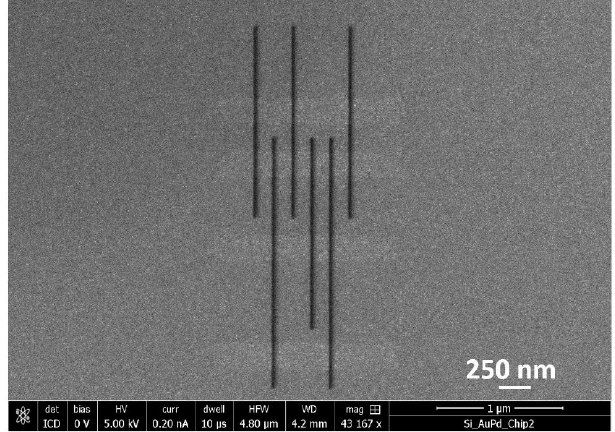
BSE (b) images show brightening in the exposed regions and the integrated AFM line scan of the line profile in the etched region with the as-deposited profile taken on the same array. Figure 5. ( a ) AFM image with the dotted lines indicating an area at the edge of the etched region, before, with a clear reduction in background deposit visible between the lines. where the thickness of the carbon film removed is measured from ( b ) to be about 1 nm.